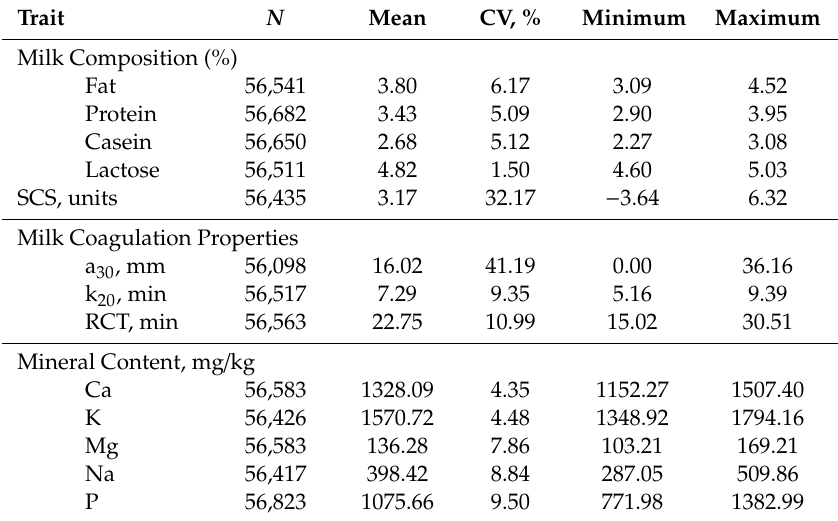
Table 1. Descriptive statistics of bulk milk